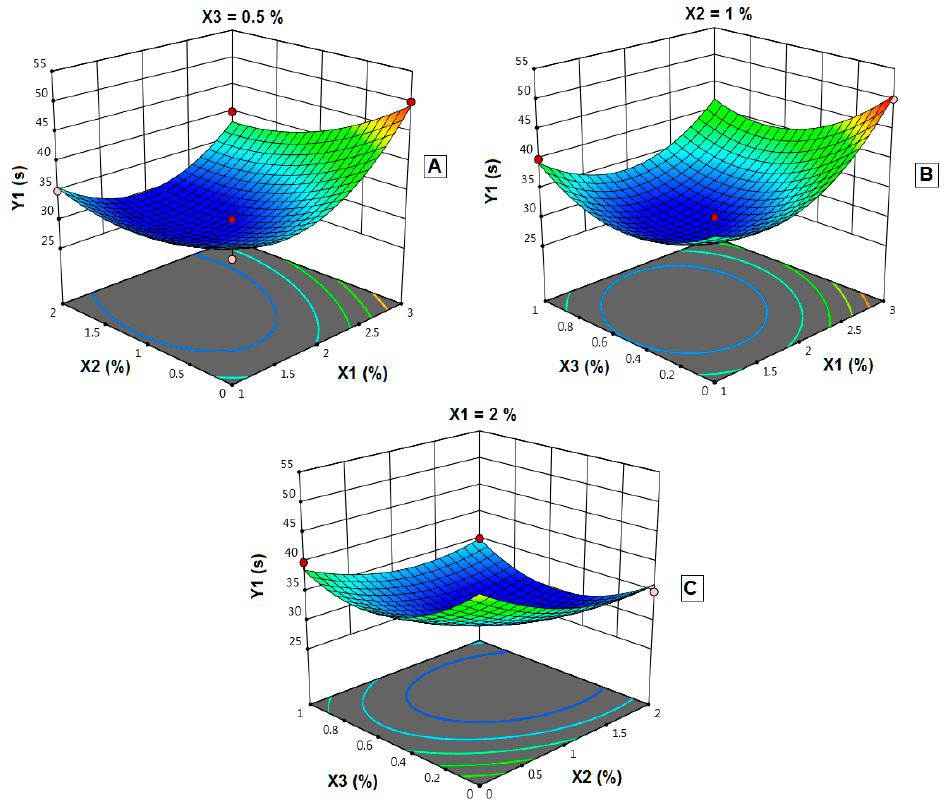
Figure 9. Effect of independent variables on the in-vitro disintegration time (Y 1 ). ( A ): Effect of polymer concentration (X 1 ) and plasticizer concentration (X 2 ) on Y 1 at 0.5% X 3 . ( B ): Effect of polymer concentration (X 1 ) and disintegrant concentration (X 3 ) on Y 1 at 1% X 2 . ( C ): Effect of plasticizer concentration (X 2 ) and disintegrant concentration (X 3 ) on Y 1 at 2% X 1 .